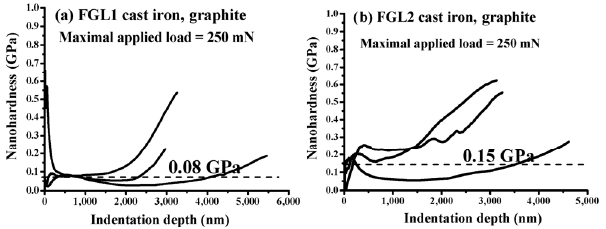
Fig. 3 Nanohardness of graphite phase in FGL1 and FGL2 cast irons.